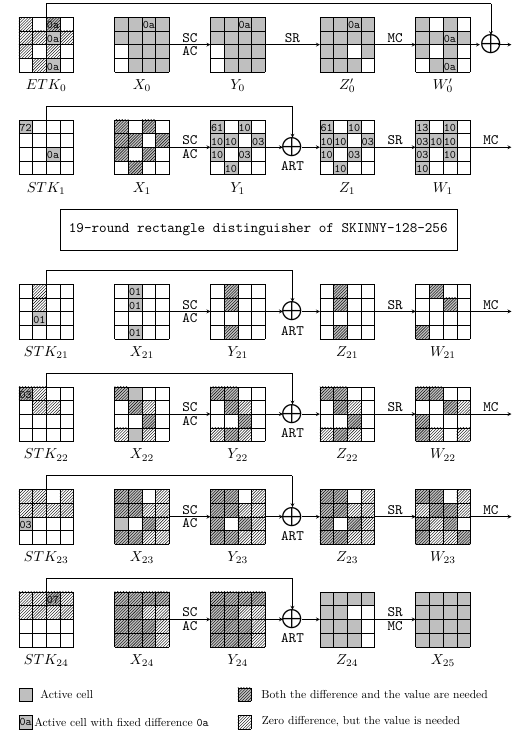
Figure 10: The 25-round attack against SKINNY-128-256